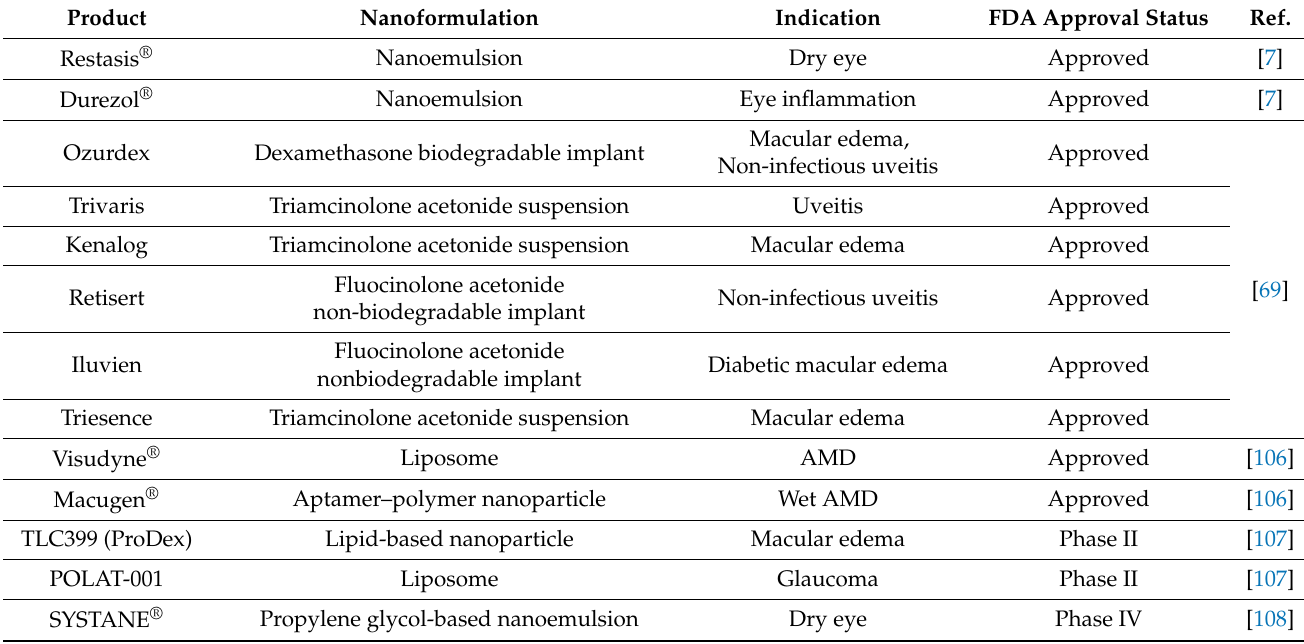
Table 3. Nanomedicine for ocular diseases under clinical trial and approved by FDA. Product